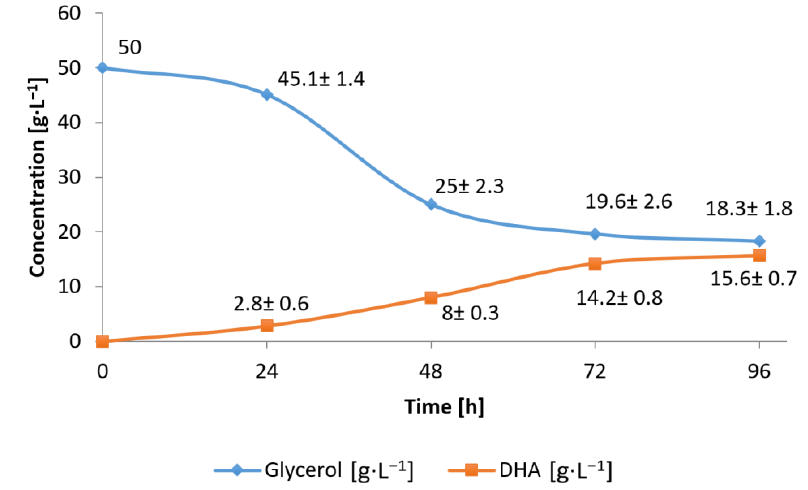
Figure 5. Time profiles of g l ycerol conversion and DHA formation during conversion of 50 g·L −1 of a waste g l ycerol fraction with immobilized G. oxydans cells.